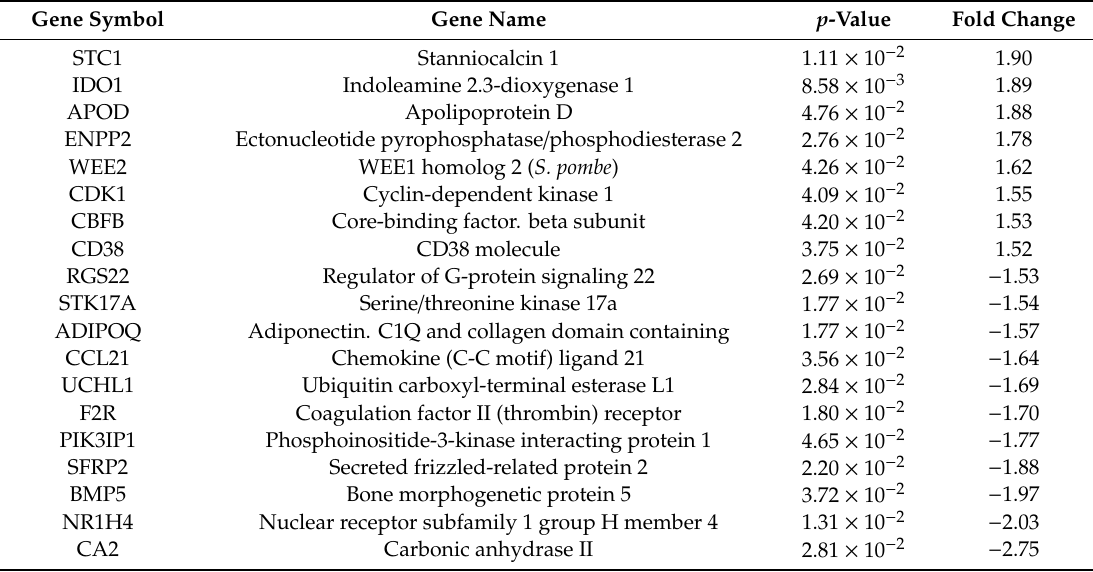
Table 3. Nineteen significant di ff erentially expressed genes involved in cell death in ovarian